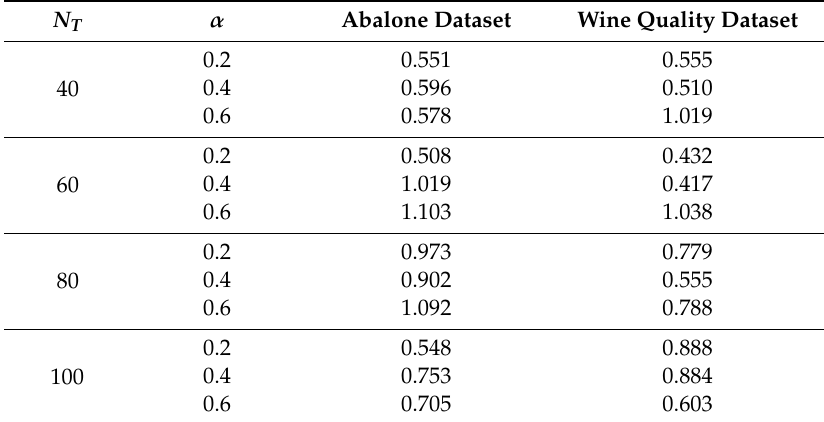
Table 6. Cohen (cid:48) s d using the proposed method and bagging.